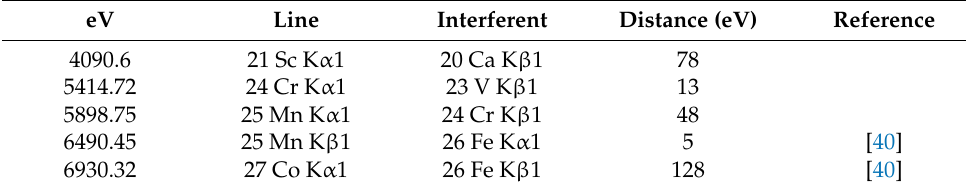
Table 4. Potential K α /K β interferences (keV) [34].